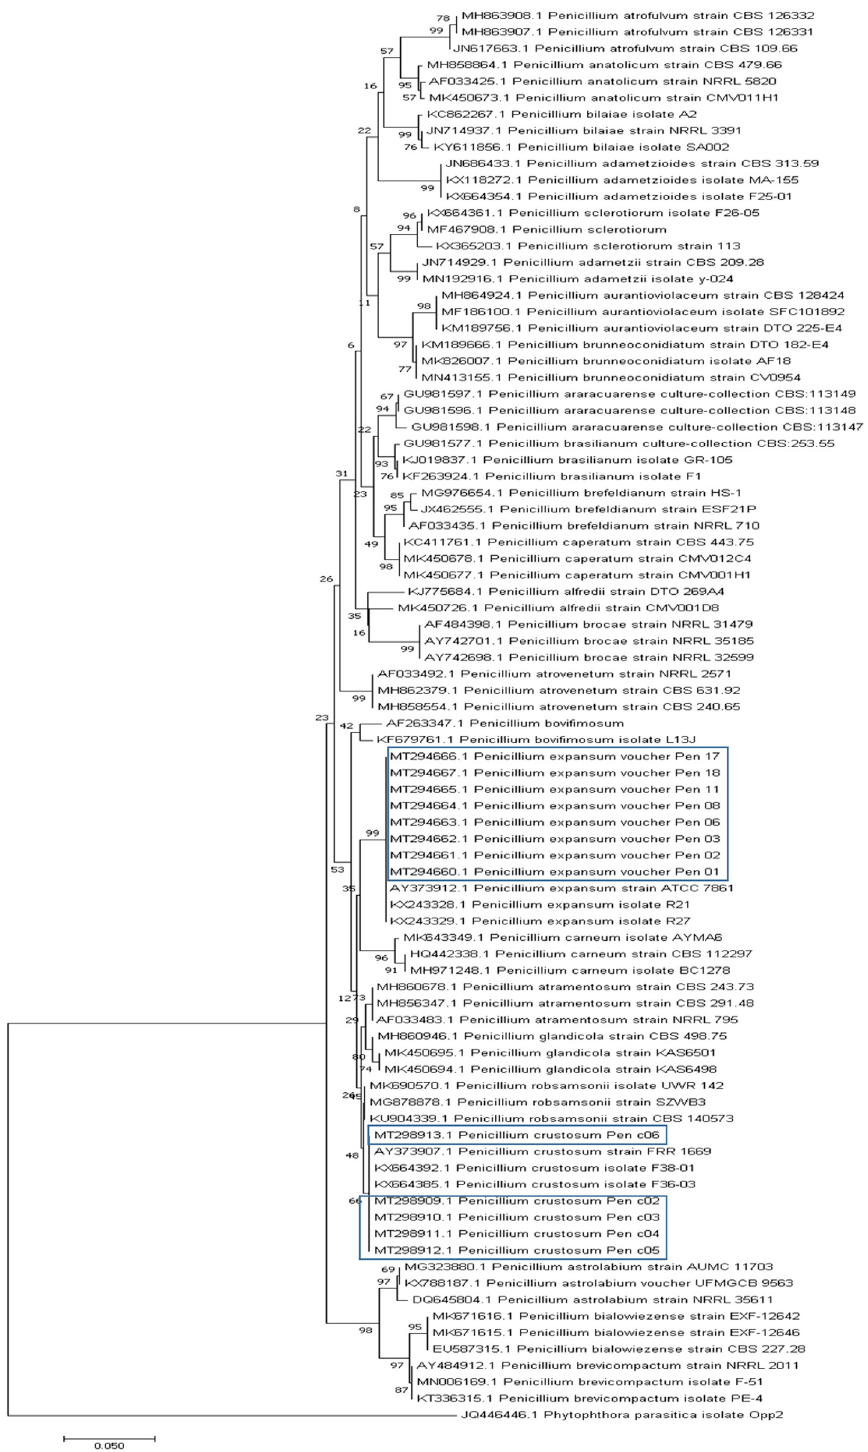
Figure 3: Phylogenetic tree based upon MUSCLE alignment of the ITS region of rDNA nucleotide sequences of Penicillium isolates causing blue mold disease of grapes. The evolutionary history was inferred using the neighbour - joining method. The optimal tree with the sum of branch length = 0.995574 is shown. The percentage of replicate trees in which the associated taxa clustered together in the bootstrap test ( 1,000 replicates ) is shown next to the branches. The tree is drawn to scale, with branch lengths in the same units as those of the evolutionary distances used to infer the phylogenetic tree. The evolutionary distances were computed using the Maximum Composite Likelihood method and are in the units of the number of base substitutions per site. The analysis involved 86 nucleotide sequences. All positions containing gaps and missing data were eliminated. There were a total of 275 positions in the fi nal dataset. Evolutionary analyses were conducted in MEGA7. The tree is rooted with Phytophthora parasitica isolate ( JQ446446.1 )